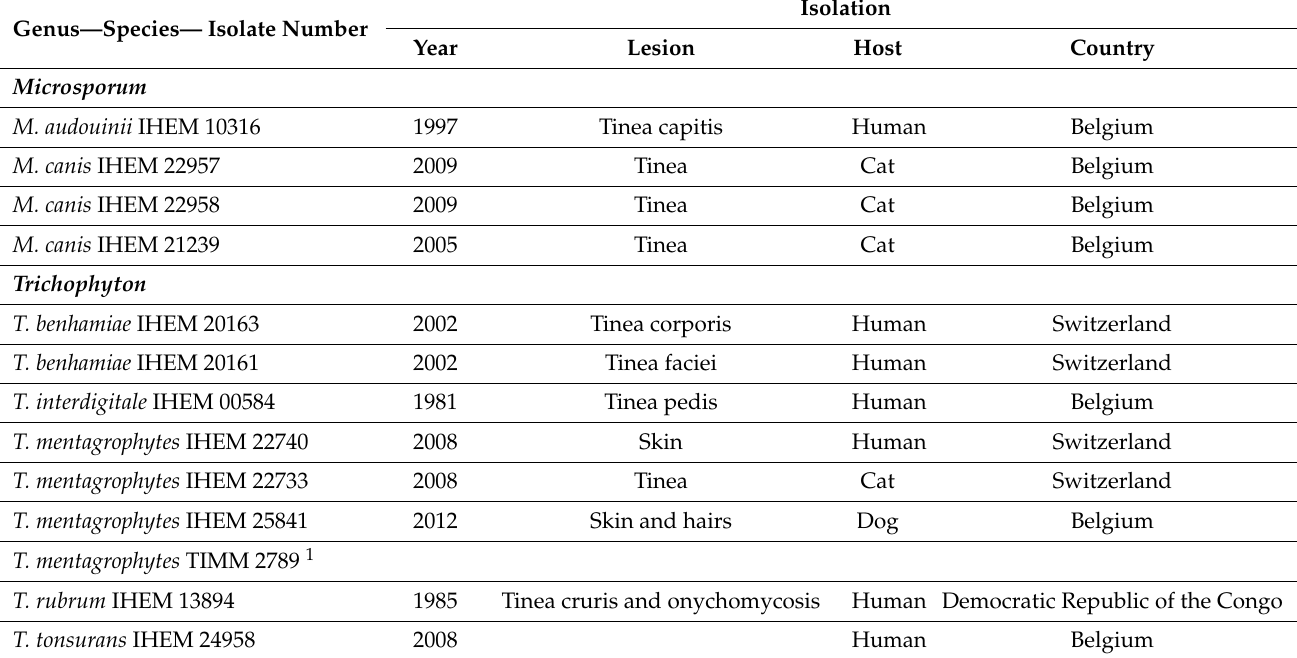
Table 1. Dermatophyte isolates analysed in this study. Information on each isolate was retrieved from the online catalogue of Belgian Coordinated Collections of Micro-organisms (BCCM)/Institute of Hygiene and Epidemiology-Mycology section (IHEM; https://bccm.belspo.be/catalogues/ihem-catalogue-search; accessed on 1 September 2021).